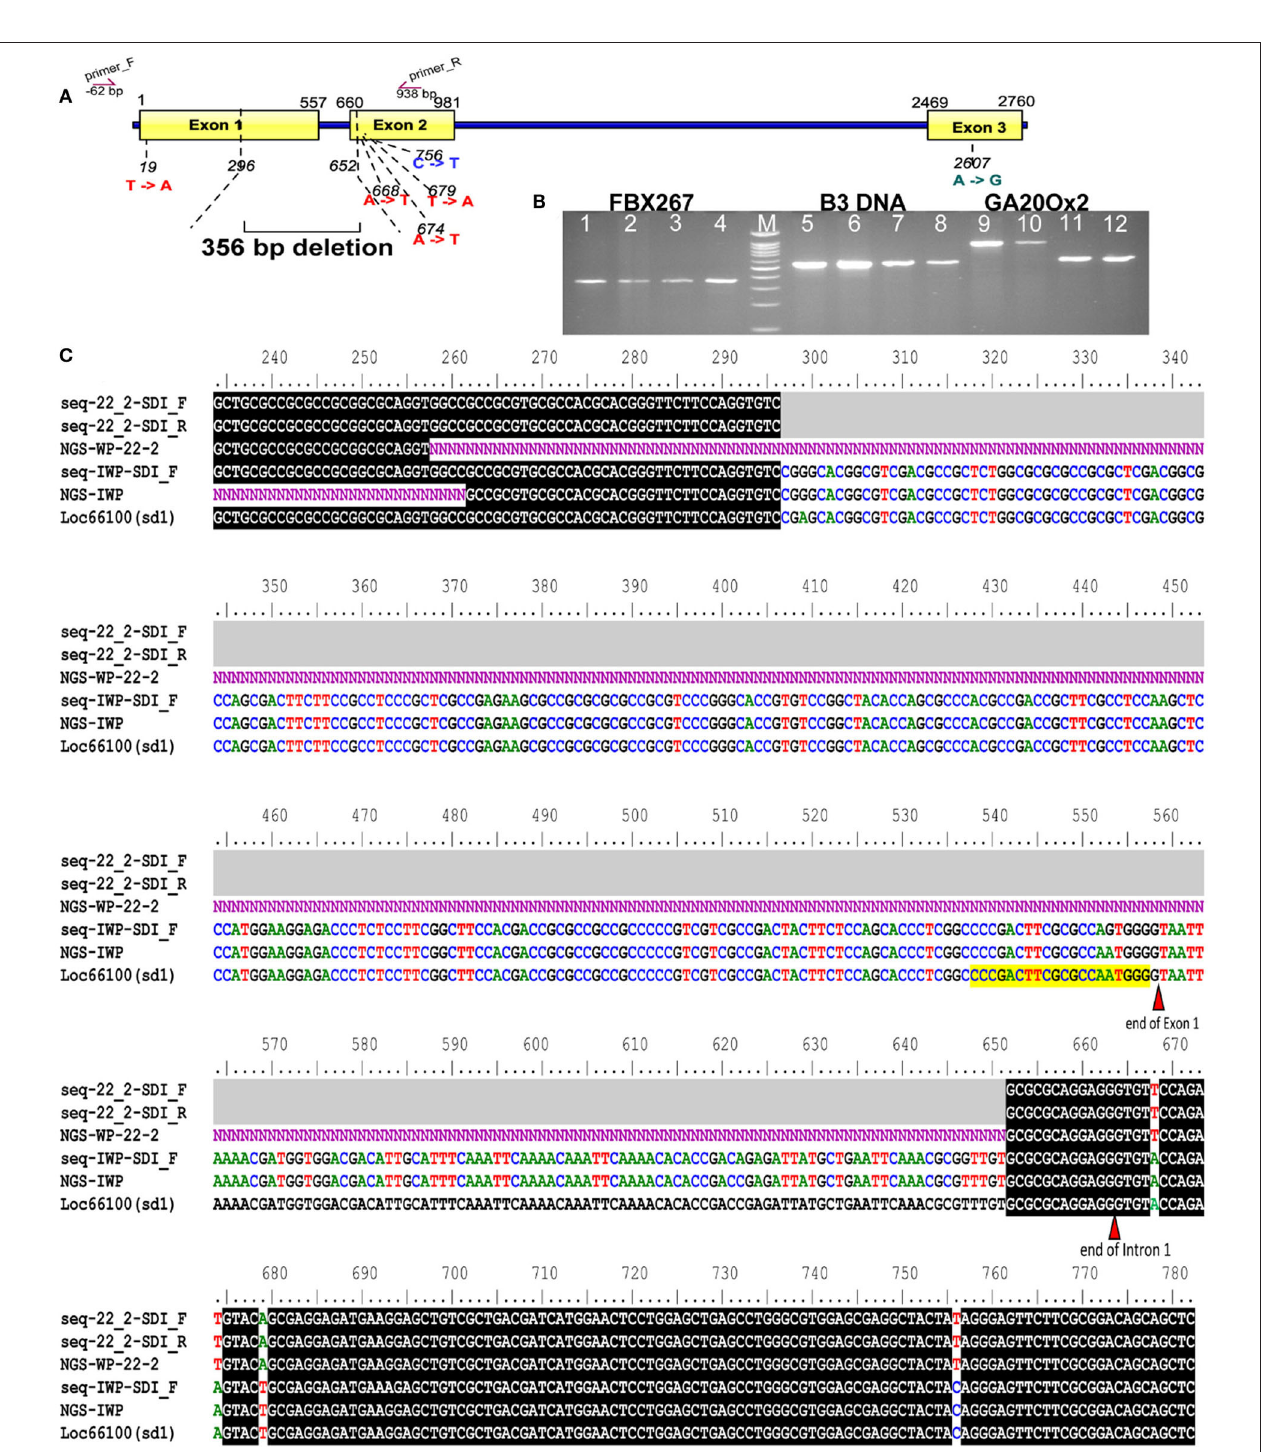
FIGURE 3 | Gene illustration and sequence alignment of SD1 locus. (A) Gene illustration showing the regions of deletion and other single nucleotide variations between IWP and WP-22-2; binding sites of the primer used for Sanger sequencing are marked as arrows above the gene diagram. (B) Cropped gel image of B3 DNA, FBX267, and GA20Ox2 gene regions of IWP and WP-22-2 (biological duplicates) amplified with PCR primers; IWP: 1 and 2, 5 and 6, 9 and 10; WP-22-2: 3 and 4, 7 and 8, 11 and 12; M: 100 bp ladder—each band represents a 100-bp increment from the lower band; a large deletion is observed between IWP and WP-22-2 in the GA20Ox gene (Full-length gel image is presented in Supplementary Material 10 ). (C) Sequence alignments showing single nucleotide variations. The horizontal gray bars indicate (in seq-22_2-SD1_F and seq-22_2-SD1_R) deletion. Order of alignment: Sanger (WP-22-2_F&R) , NGS WP-22-2 , Sanger IWP , NGS IWP and annotated Nipponbare LOC_Os01g66100